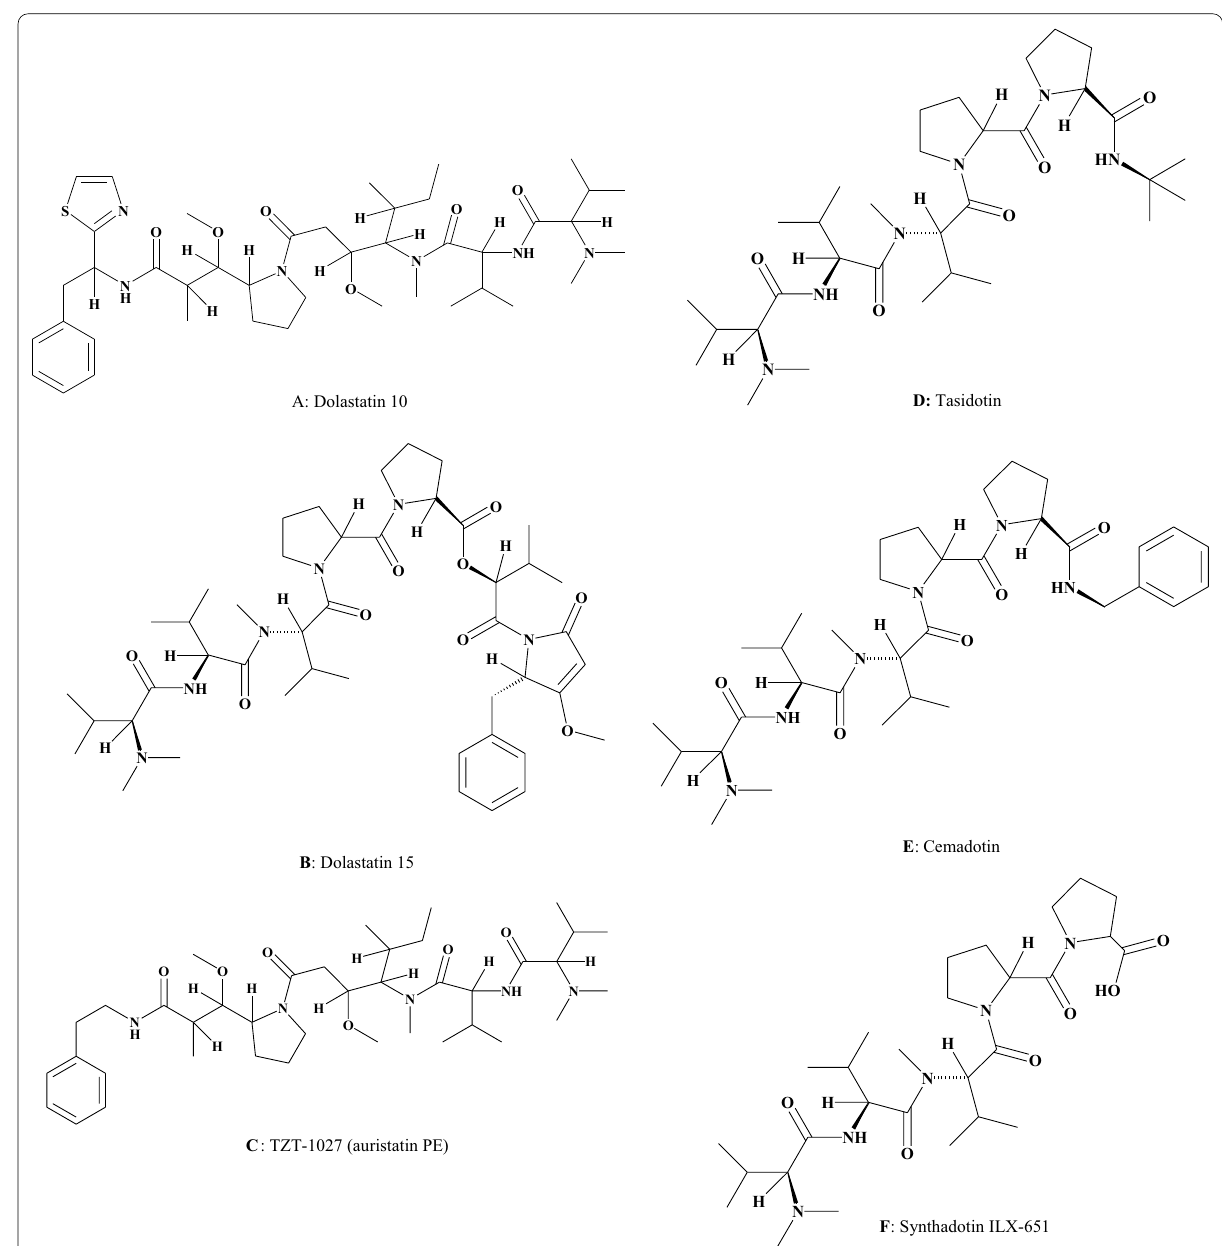
Fig. 2 a . Chemical structure of the marine Sea hare Dolabella auricularia, Dolastatin 10. b . Chemical structure of the marine Sea hare Dolabella auricularia, Dolastatin 15. c Chemical structure of an analog of Dolastatin 10, TZT‑1027 (auristatin PE). d Chemical structure of an analog of Dolastatin 10, Tasidotin. e Chemical structure of an stabilized analog of dolastatin 15 Cemadotin. f Chemical structure of an dolastatin 15 synthetic analog Synthadotin